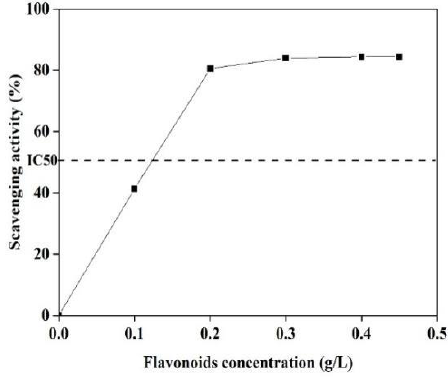
Figure 6. DPPH free radical scavenging ability of BRF with different concentrations of